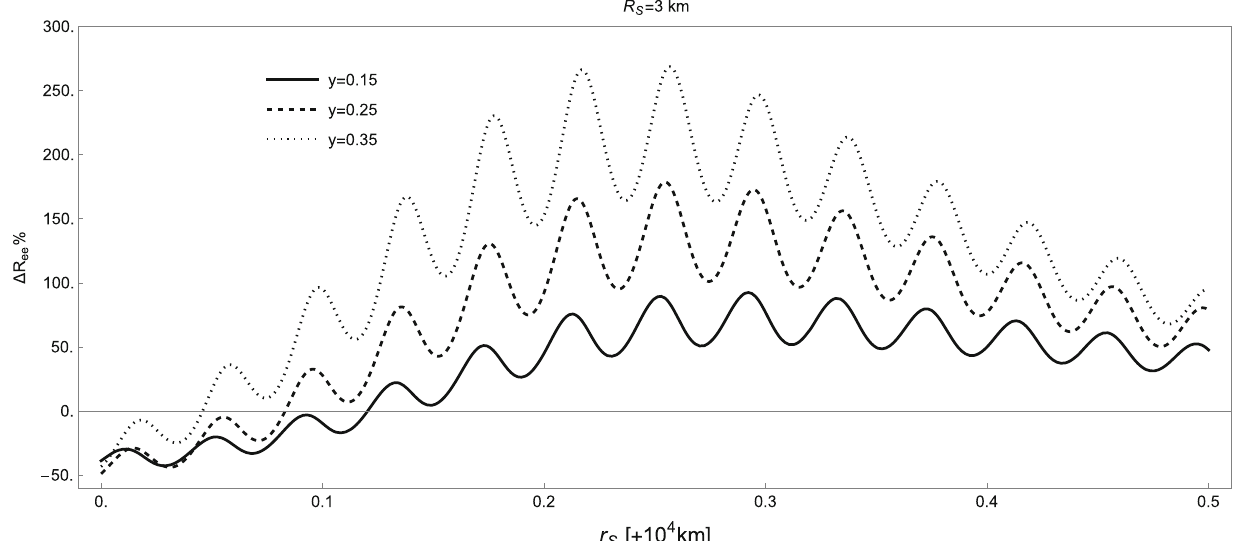
the detector is located at r D = 10 8 km. Other parameters are R s = 3 = 0 . 4 E = 0 . 1 MeV. The values of neu- km, p T loc MeV/c, and E loc loc trino mass squared differences, mixing angle and the Dirac CP phase are taken from the (NuFIT 5 (2020)) global fit